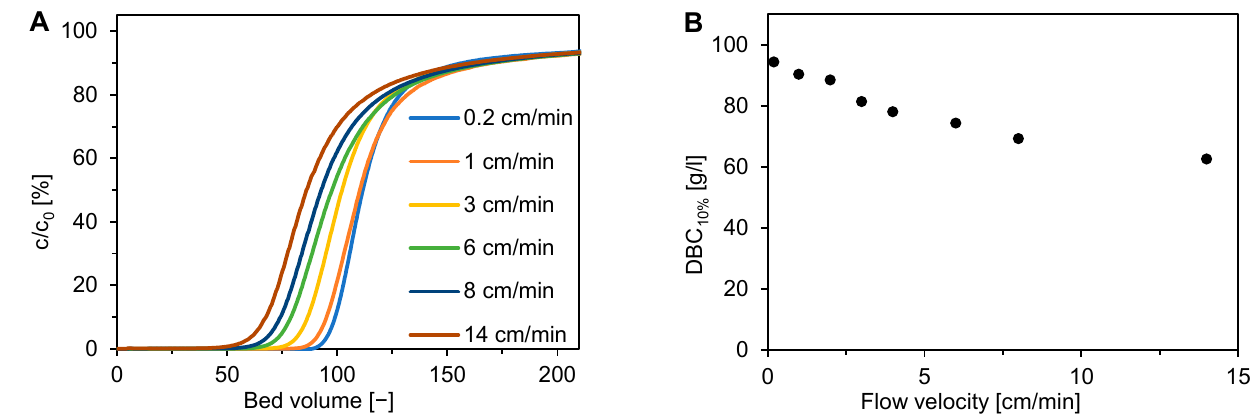
Figure 3. Effect of linear flow velocity on the adsorption of BSA on Sartobind STIC membranes in laboratory membrane modules. ( A ) Breakthrough curves for BSA adsorption. ( B ) Dynamic binding capacity at 10% breakthrough.